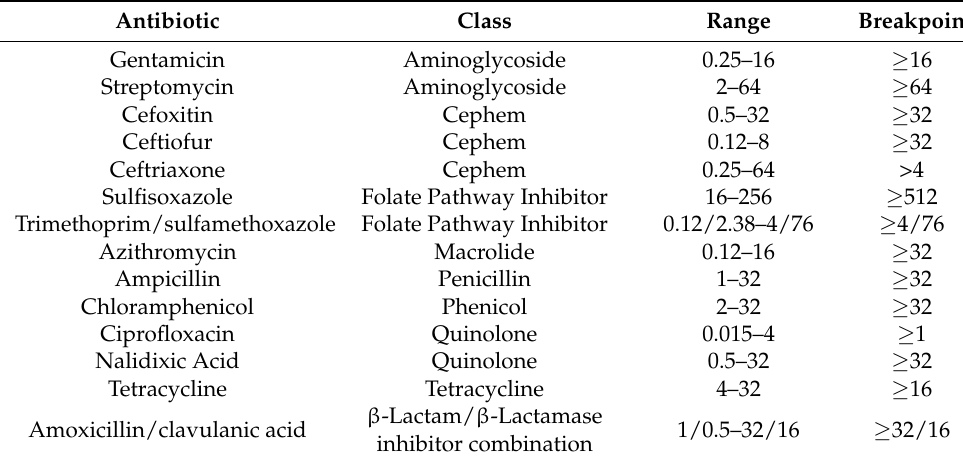
Table 2. Antibiotics ordered by class, concentration ranges (mg/L) and interpretive breakpoints (for resistance) for NARMS Gram-negative plate (CMV3AGNF), using CLSI criteria and NARMS interpretive human breakpoints when a CLSI equivalent was